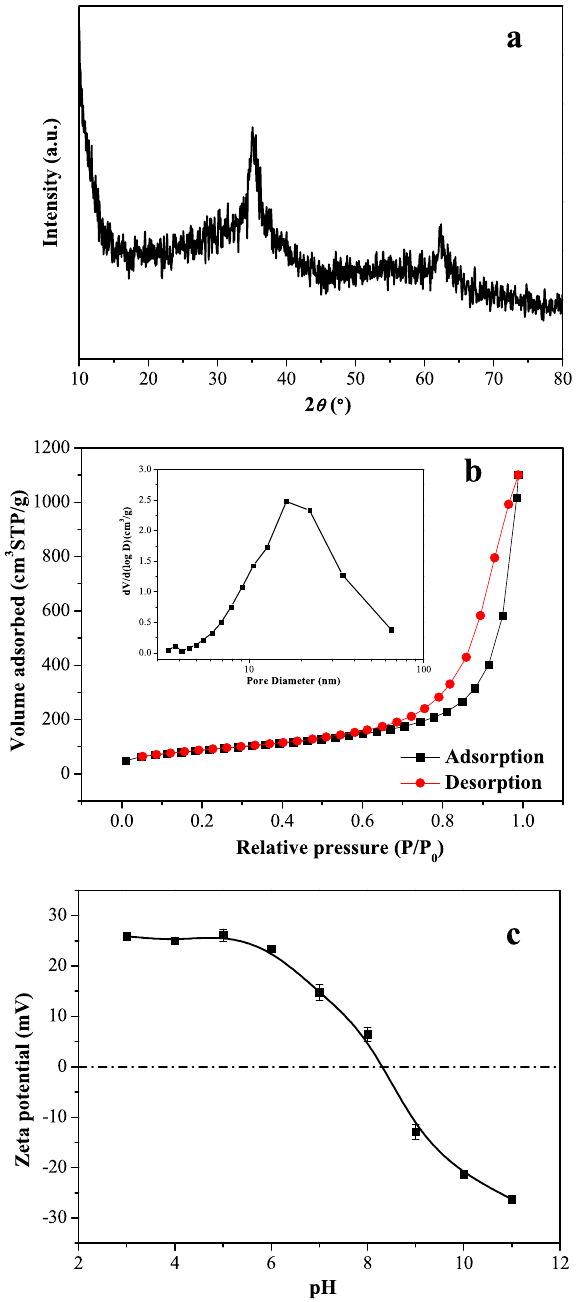
Figure 2. XRD pattern ( a ), N 2 adsorption–desorption isotherms and pore size distributions (inset) based on BJH analysis ( b ) and zeta potentials ( c ) as a function of pH of the iron hydroxide nanopetalines.